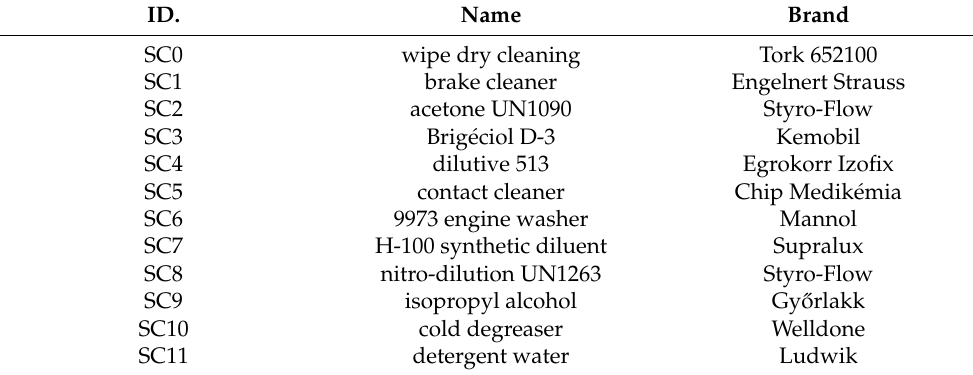
Table 1. Surface preparation materials and processes.